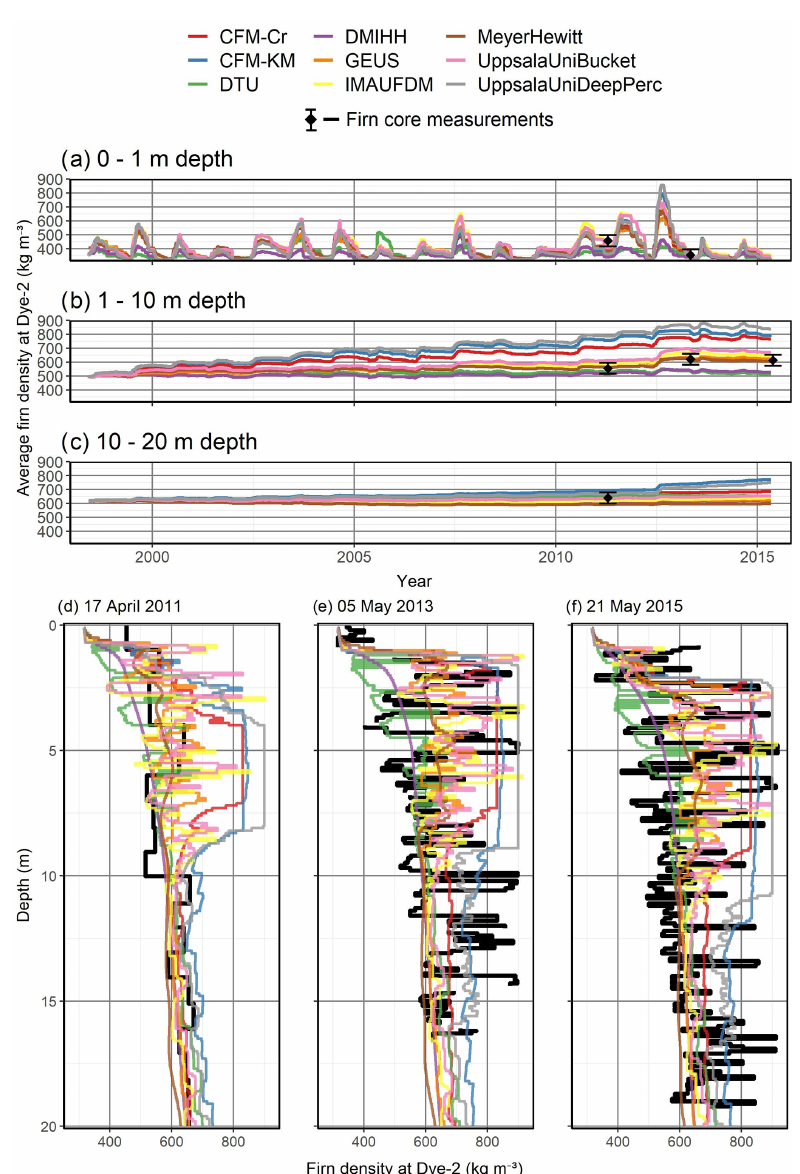
Figure 5. Modeled (colored lines) and observed (black diamonds with 40kgm − 3 uncertainty bars) average firn density for the top 1m (a) , the 1–10m depth range (b) and the 10–20m depth range (c) at Dye-2_long. Observed and simulated firn density profiles at Dye-2_long (d–f)